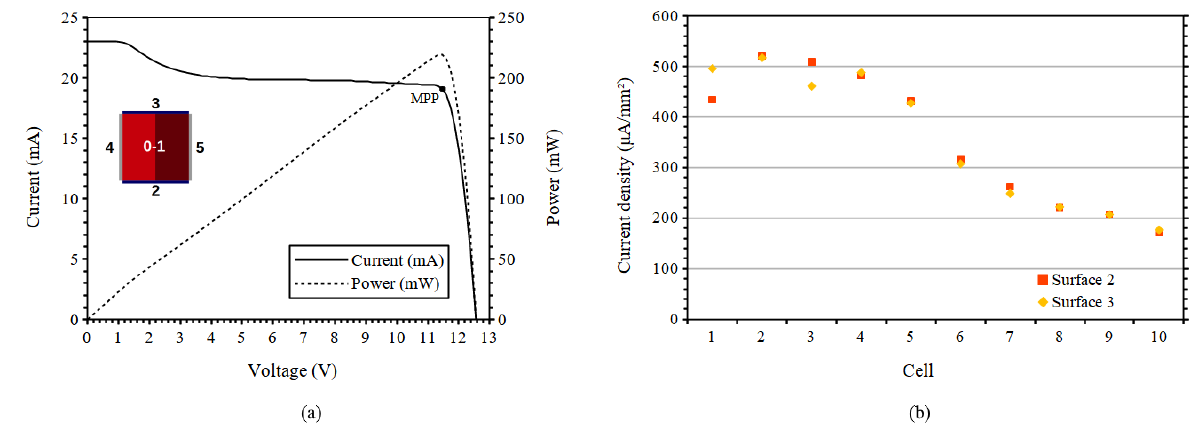
Figure 23. Shaded LSC panel with two 10-cells PV arrays, shading across the PV arrays: ( a ) characteristic curves (I-V and P-V), ( b ) current density produced by each PV cell.